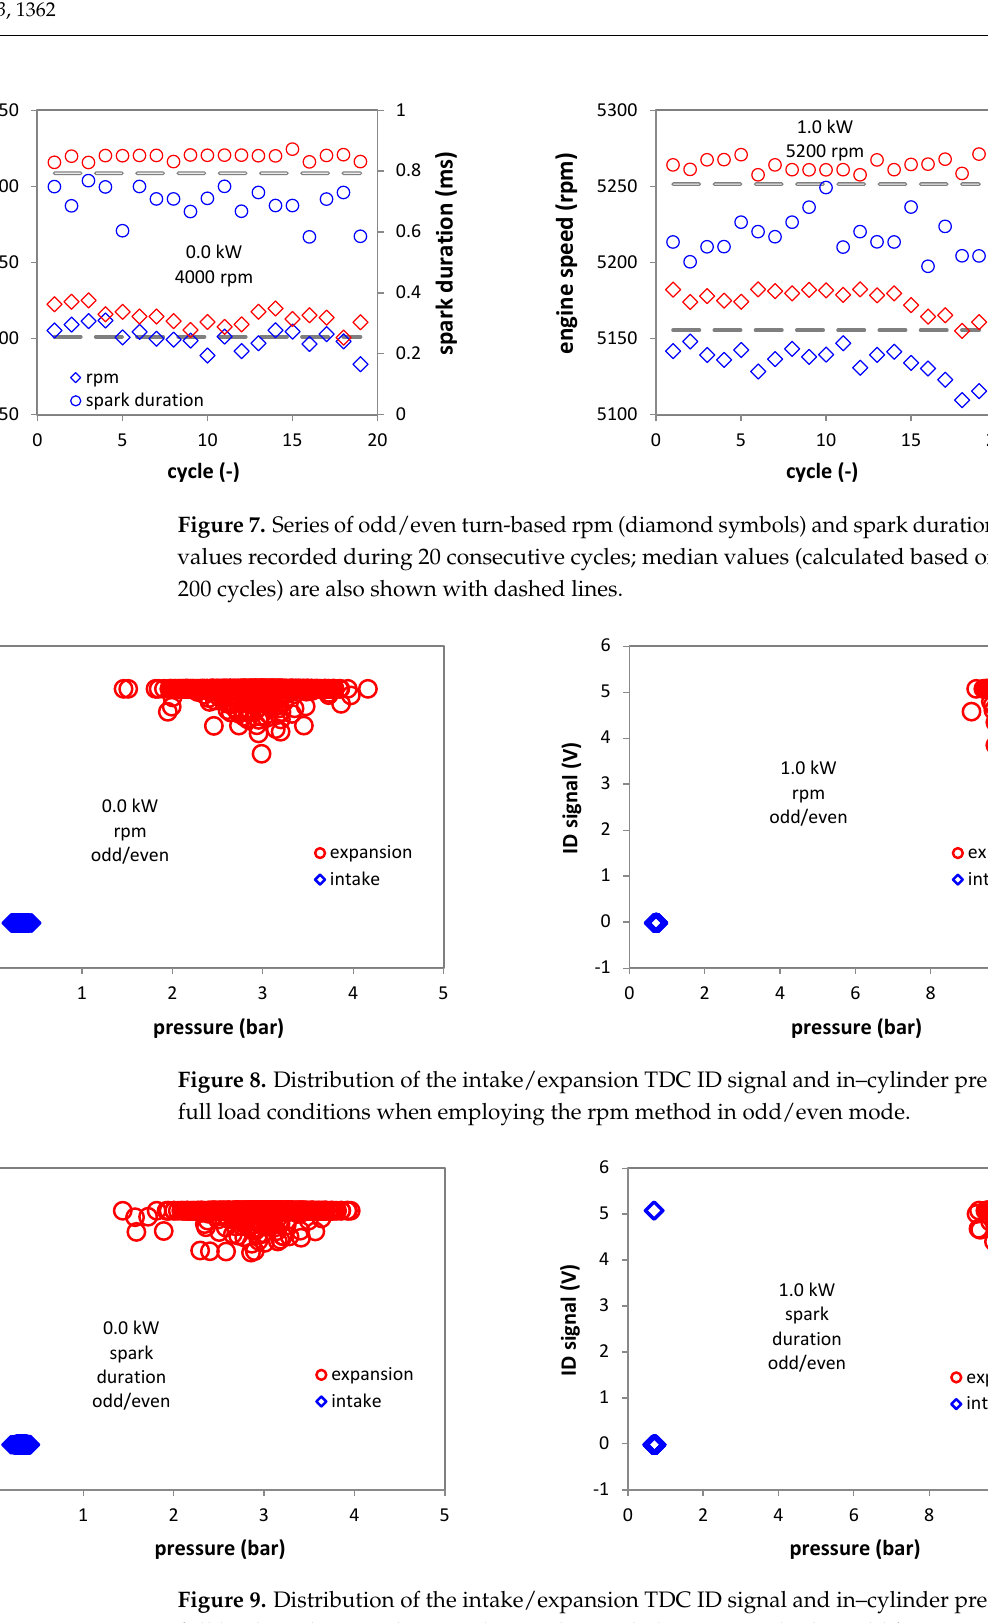
Figure 9. Distribution of the intake/expansion TDC ID signal and in–cylinder pressure for idle and full load conditions when employing the spark duration method in odd/even mode.